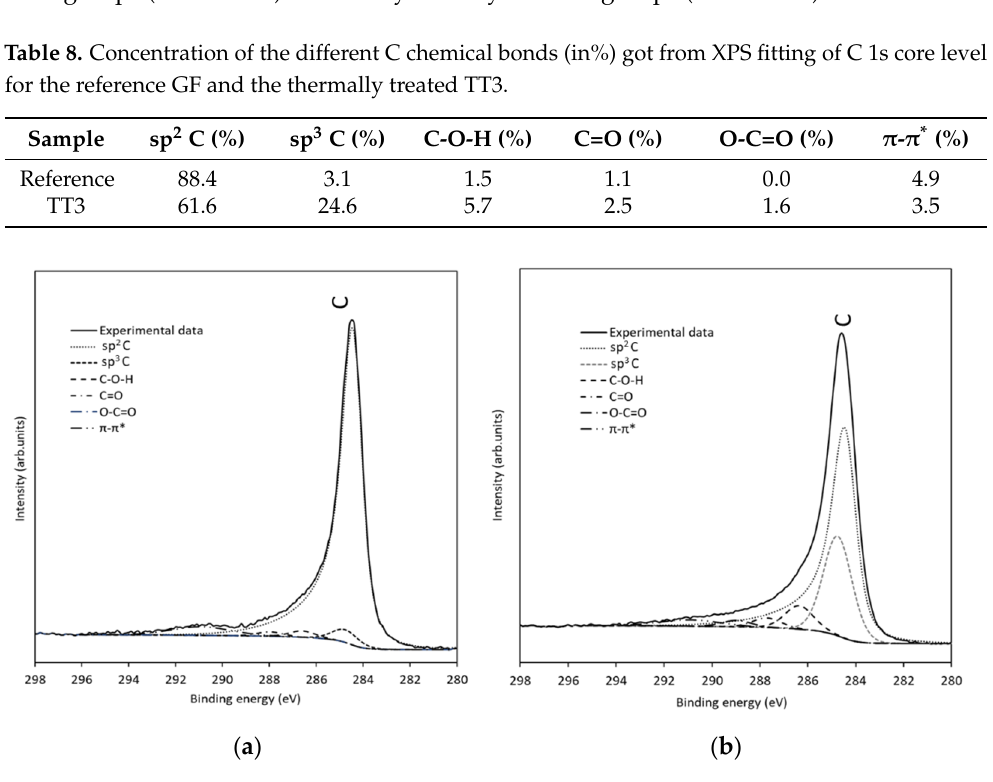
Table 7. Surface elemental composition of the untreated and TT3 graphite felt calculated by XPS. Sample Reference